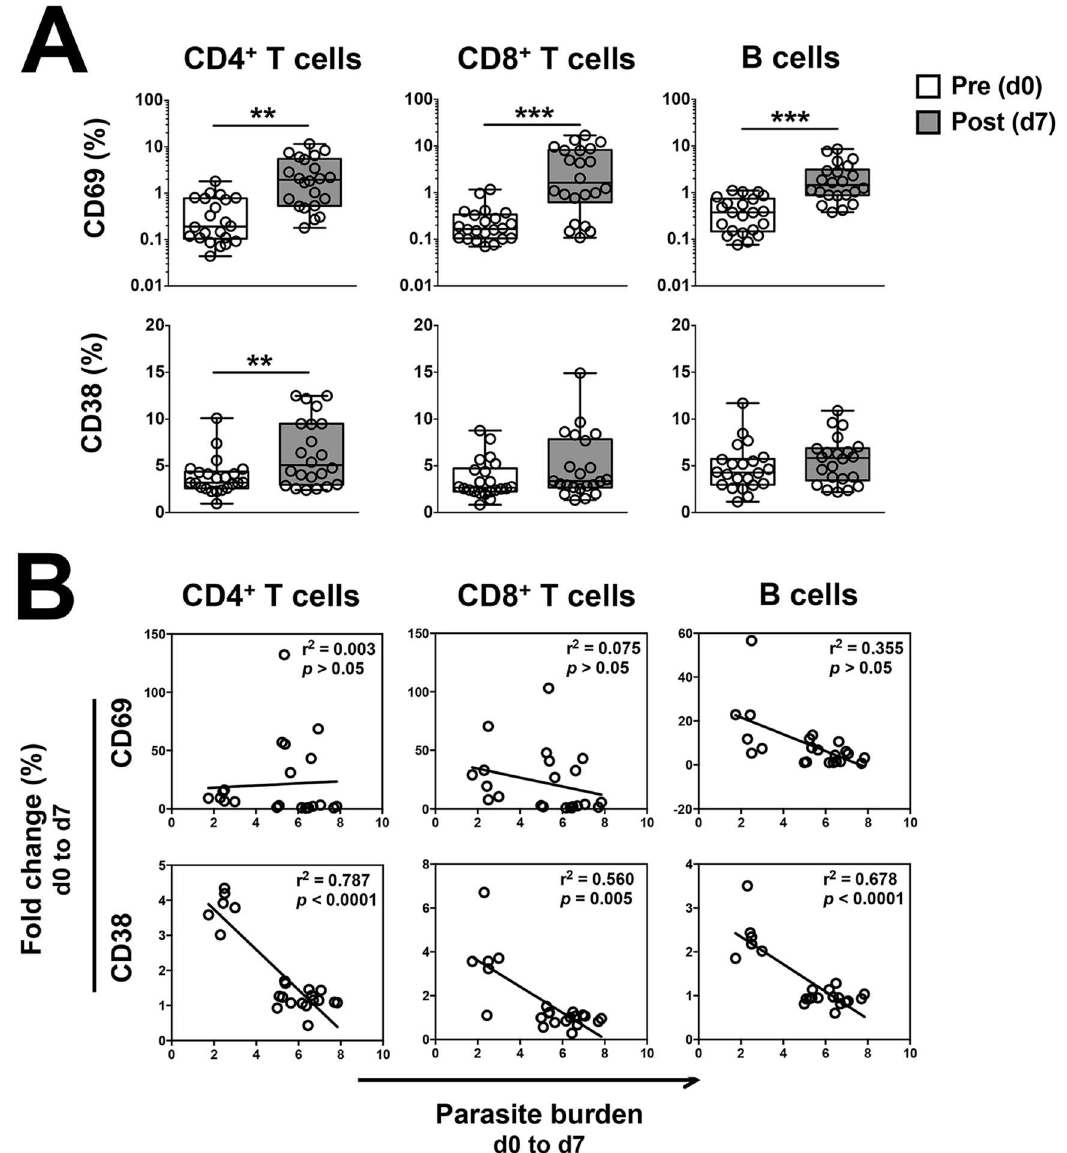
Fig 1. Changes in the frequency of CD69 + and CD38 + T cellsand B cellscirculatingduring P . falciparum blood- stageinfectionand theirassociationwithparasite burden. Peripheral blood was collectedpriorto and seven days post-infection of malaria-na ï ve individualswith ~ 1800 pRBCs and the frequencyof CD69 + or CD38 + T cells and B cells determined by flow cytometry. Parasite burden was calculatedas the Area Under the Curve fromblood parasitelevels measuredby qPCR fromday 0 to day 7 post-infection. (A) Frequency of CD69 + or CD38 + T cells and B cells circulating pre-and post-infection. (B) Univariate regressionanalysisof the changes in frequencyof CD69 + or CD38 + T cells and B cells circulating duringinfection and parasiteburden. Statistical differences between cell frequencies pre-and post- infection were determinedusing the non-parametricWilcoxon test;box and whisker plots indicatemedian,interquartile range and min-max. Univariateregressionanalysis was performed with R, and p values adjustedfor multiple comparisons using the Bonferronimethod.Graphs show combineddata from22 volunteers fromfive independent cohorts. ** , p < 0.01; *** , p < 0.001.